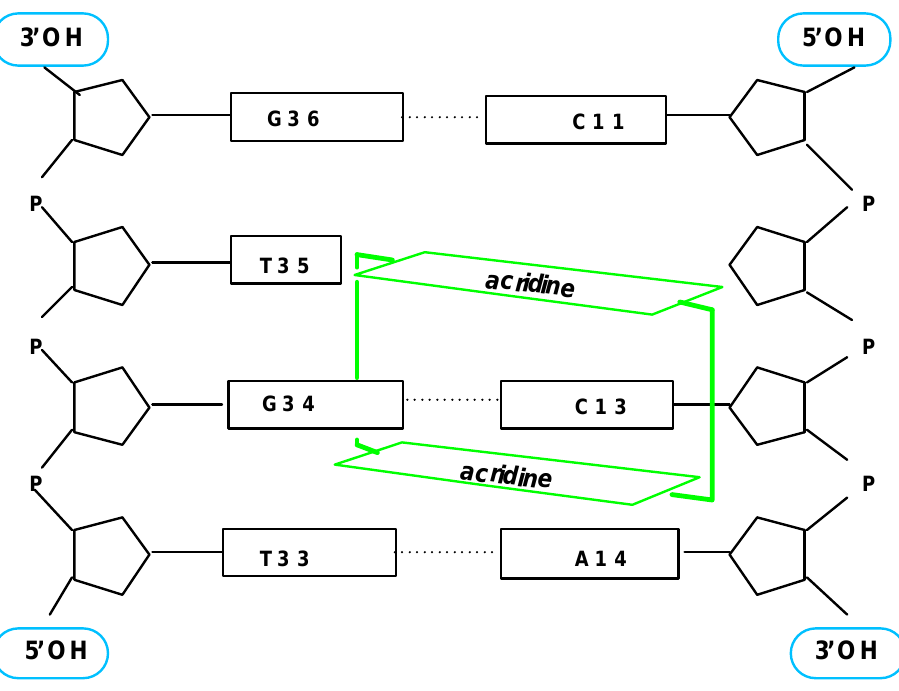
Figure 14. Schematic representation of the major DNA-Bisacridine complex